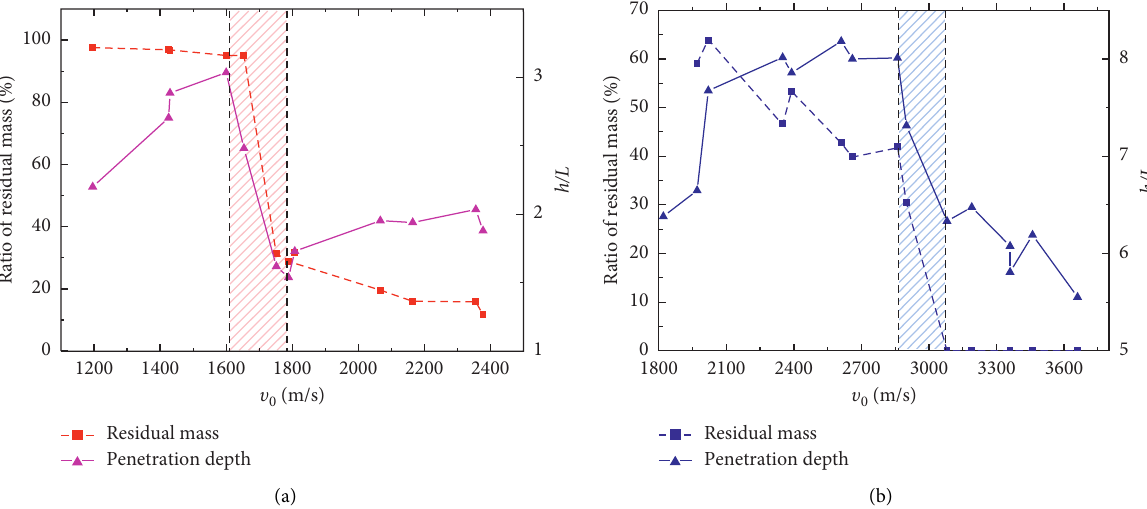
Figure 4: Curves of DOP and the ratio of residual mass vs. impact velocity. (a) Data from reference [20]. (b) Data from reference